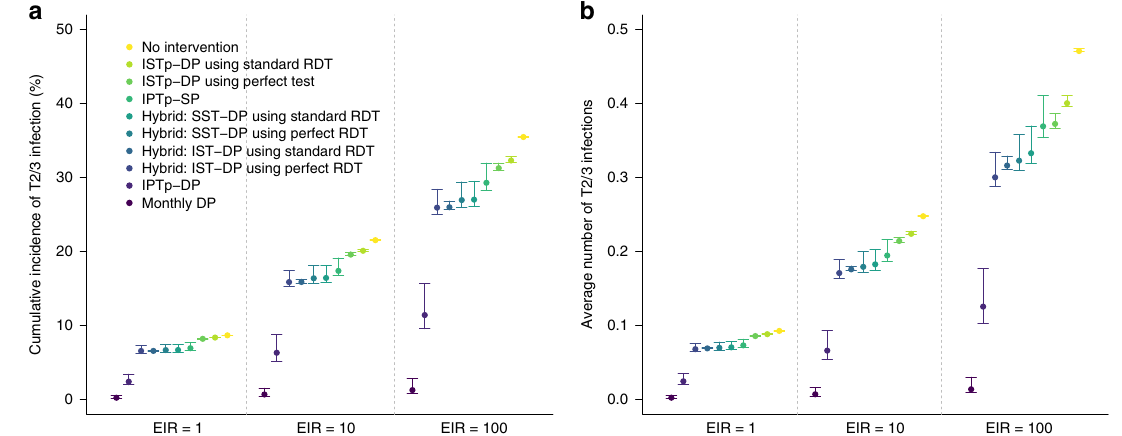
Fig. 6 Impact of different strategies upon infection later in pregnancy in areas of high quintuple SP resistance. Figure shows the impact of different simulated strategies upon the incidence of new (de fi ned as either symptomatic or asymptomatic blood-stage) infection following a fi rst ANC visit in the second trimester at 20 weeks gestation in areas of low, moderate and high transmission (EIRs of 1, 10 and 100). a Shows the percentage of women who will experience any new infection in the second or third trimester (T2/3), b shows the average number of new infections occurring throughout T2/3. Each strategy is assumed to involve three scheduled ANC visits occurring at 20, 27 and 34 weeks, except for “ Monthly DP ” (darkest blue) which involves fi ve visits spaced 30 days apart from 20 weeks onwards. A perfect test refers to a hypothetical diagnostic with perfect sensitivity and speci fi city for peripheral or placental infection. Error bars show 95% intervals based upon our uncertainty analysis for comparing the relative impact of intervention strategies (see “ Methods ”